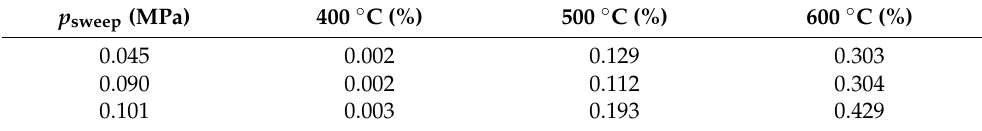
Table 3. Relationship between CH 4 conversion and p sweep with change in reaction temperature. p sweep (MPa)